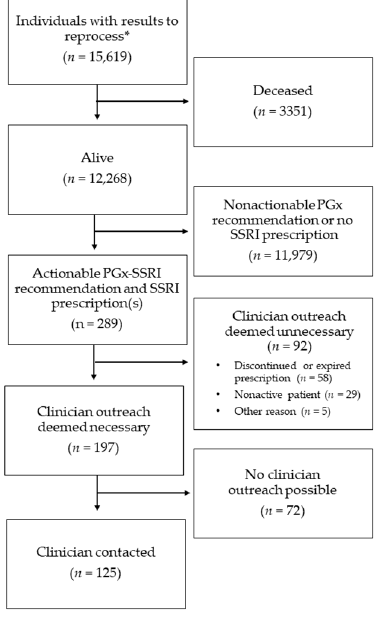
Figure 3. Flow chart of reprocessing initiative. * Reprocessing and reinterpretation included 55 pediatric patients, none of whom were on active SSRI prescriptions.